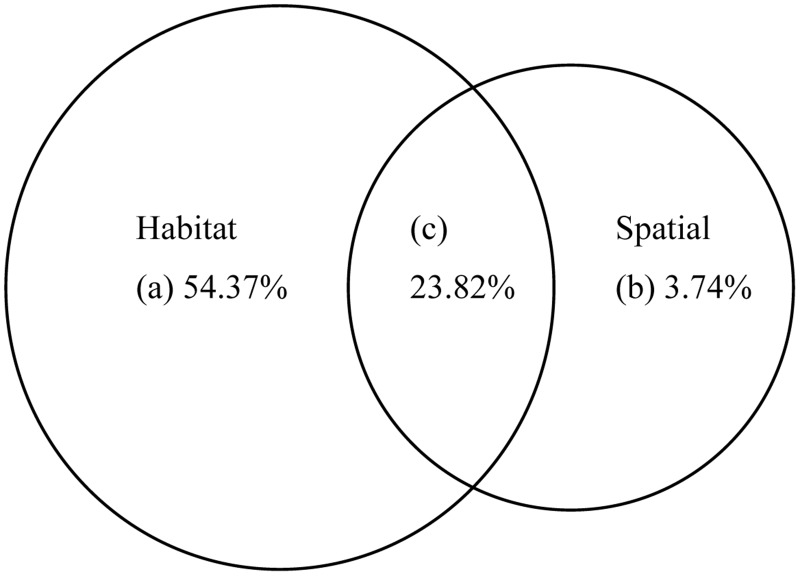
Percentages of the total variance in red-crowned crane occurrence data explained by habitat and spatial variables at the first hierarchical level.(a) The variance explained by habitat variables; (b) the variance explained by spatial variables; and (c) the variance explained by combination of habitat and spatial variables.